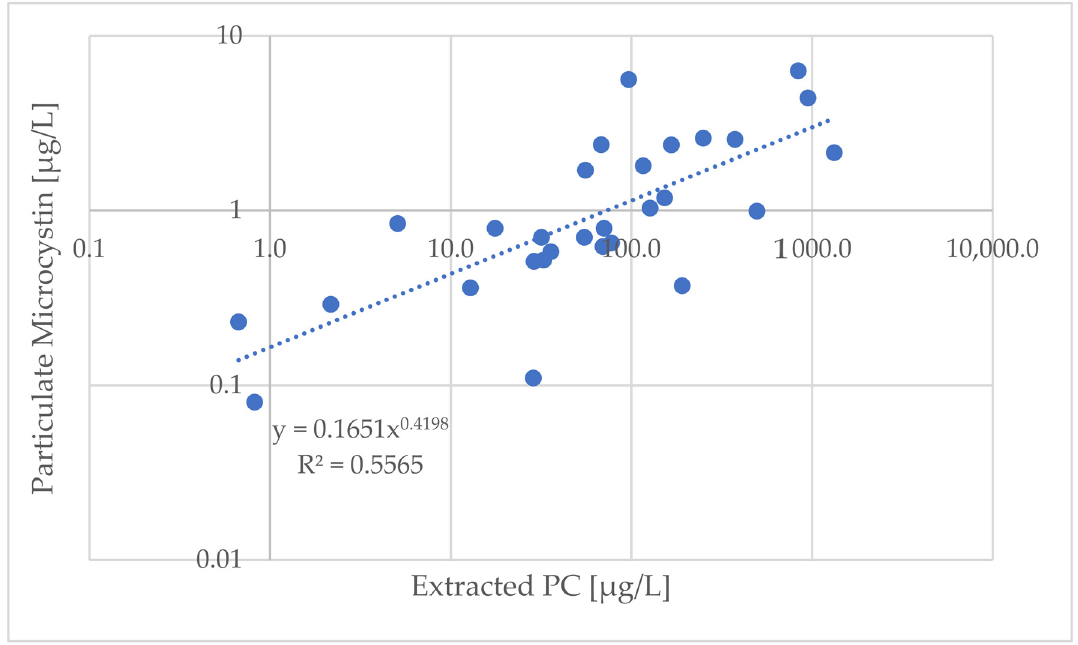
Figure 6. Correlation between extracted phycocyanin and particulate microcystin from the CIGLR data. (Data source: CIGLR).